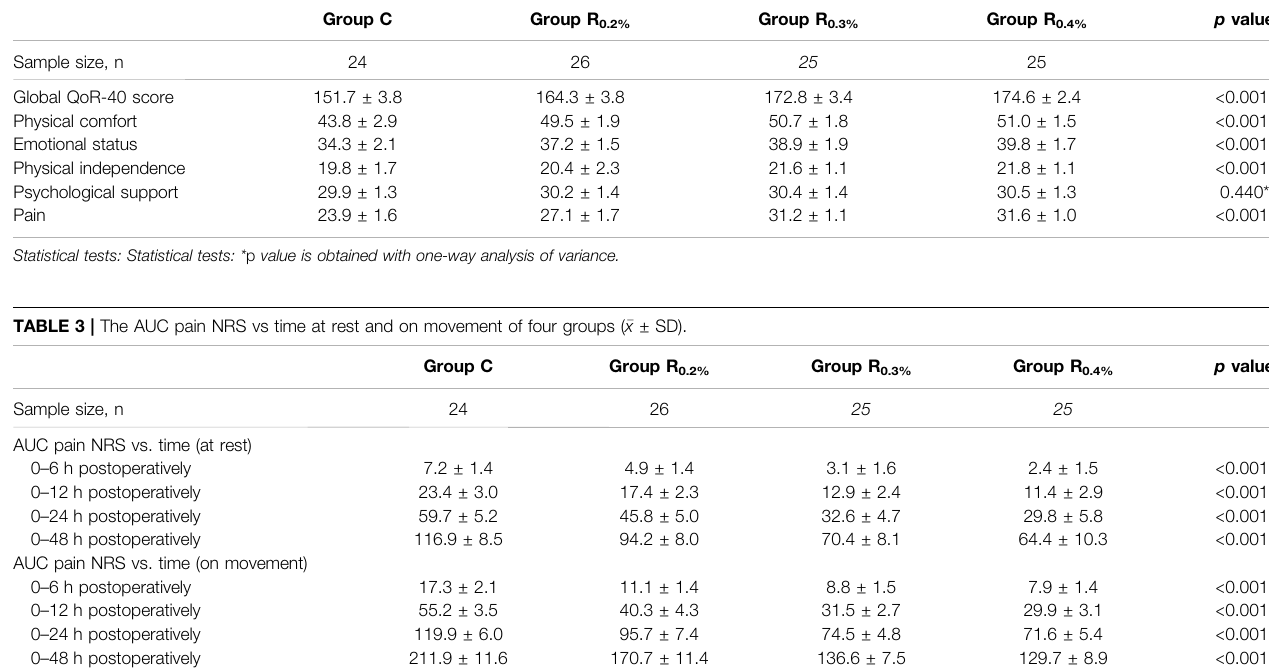
TABLE 2 | Global and dimension QoR-40 questionnaire score at 24th hour after operation in four groups ( (cid:1) x ± SD).